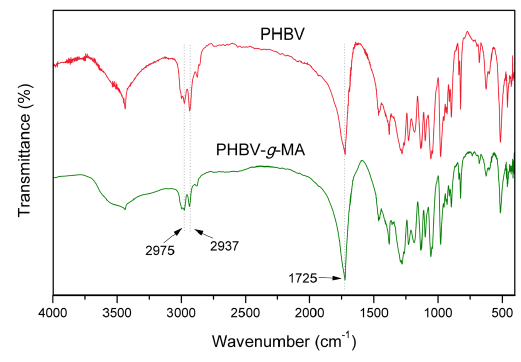
Figure 2. FTIR spectroscopy of neat PHBV and PHBV- g -